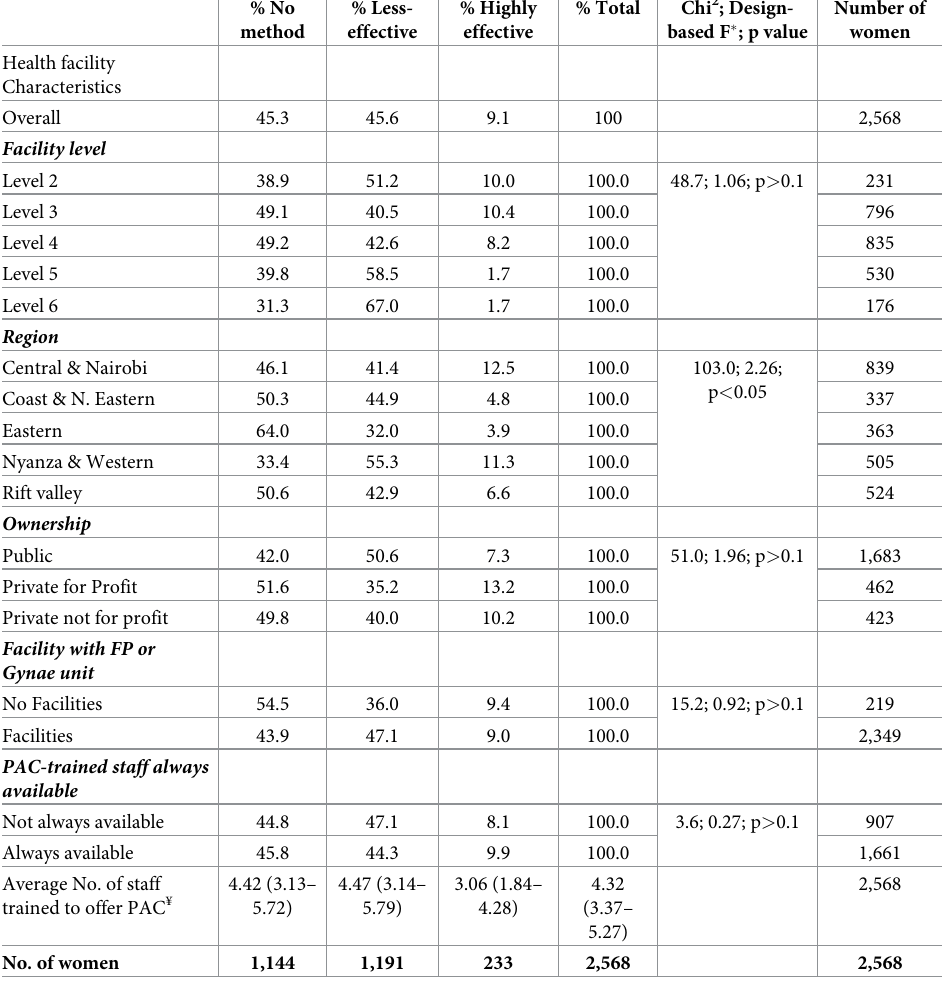
Table 3. Description of patients treated for PAC in healthcare facilities according to type of contraceptive method received, by facility characteristics,